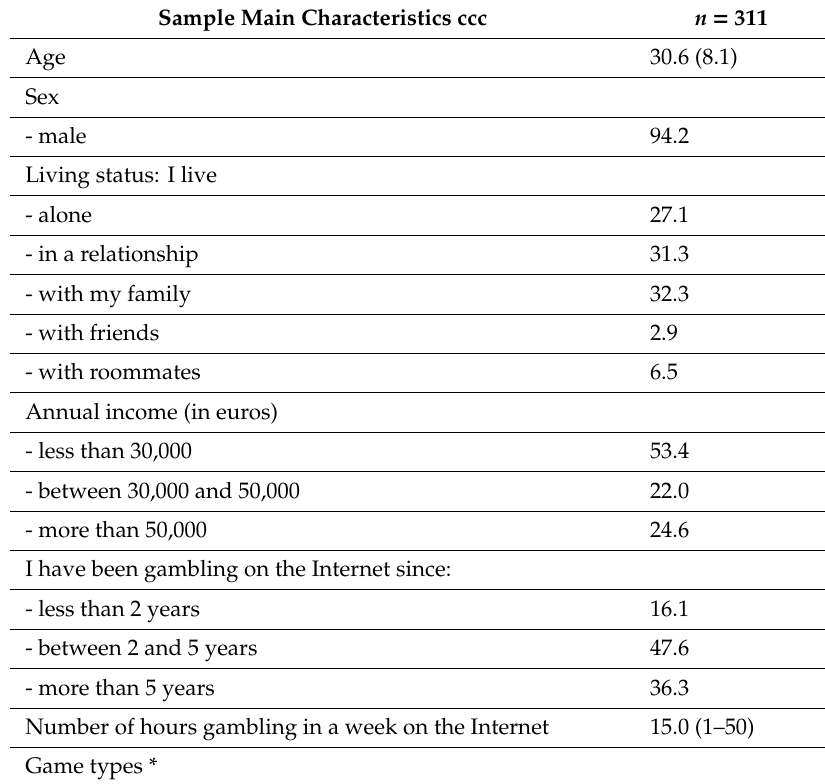
Table 1. Socio-demographics and gambling characteristics of the participants. Data are expressed as mean ( ± SD), median (range), or